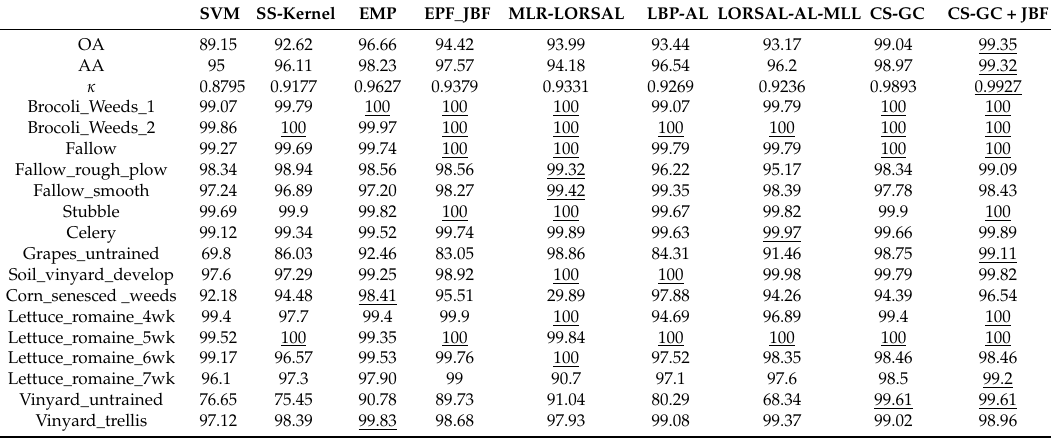
Table 4. The GAs and CAs (percent) for the Salinas data set using all the classification methods used in this work for comparison. The highest accuracies are indicated in underlined in each